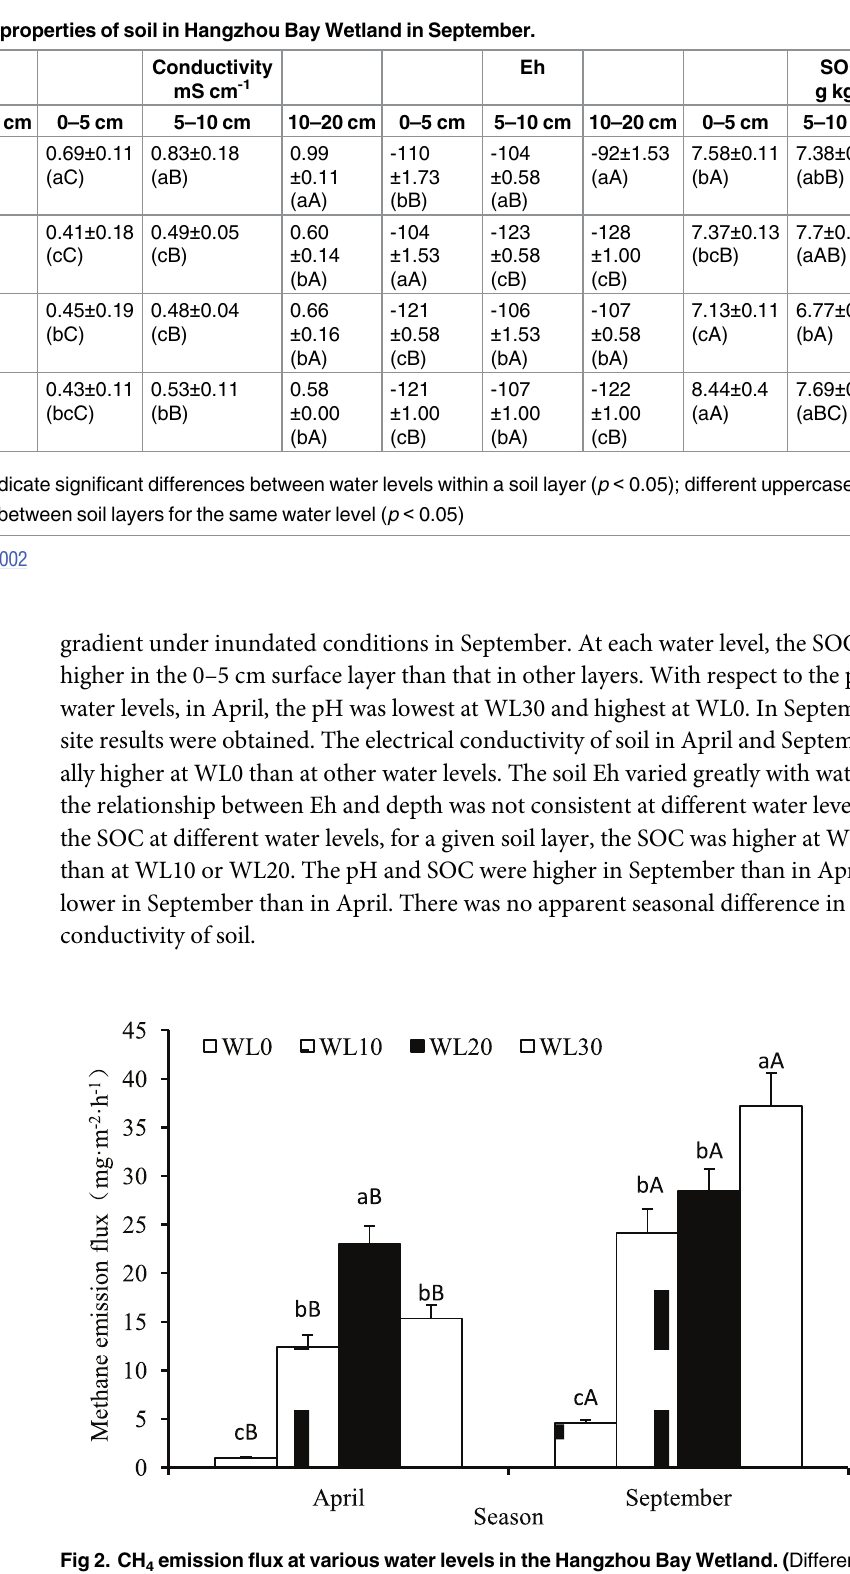
Fig 2. CH 4 emission flux at various water levels in the Hangzhou Bay Wetland. ( Different lowercase letters indicate differences betweenwater levels within a season ( p < 0.05); different upper letters indicate differences betweensamplingseasons within a water level ( p <